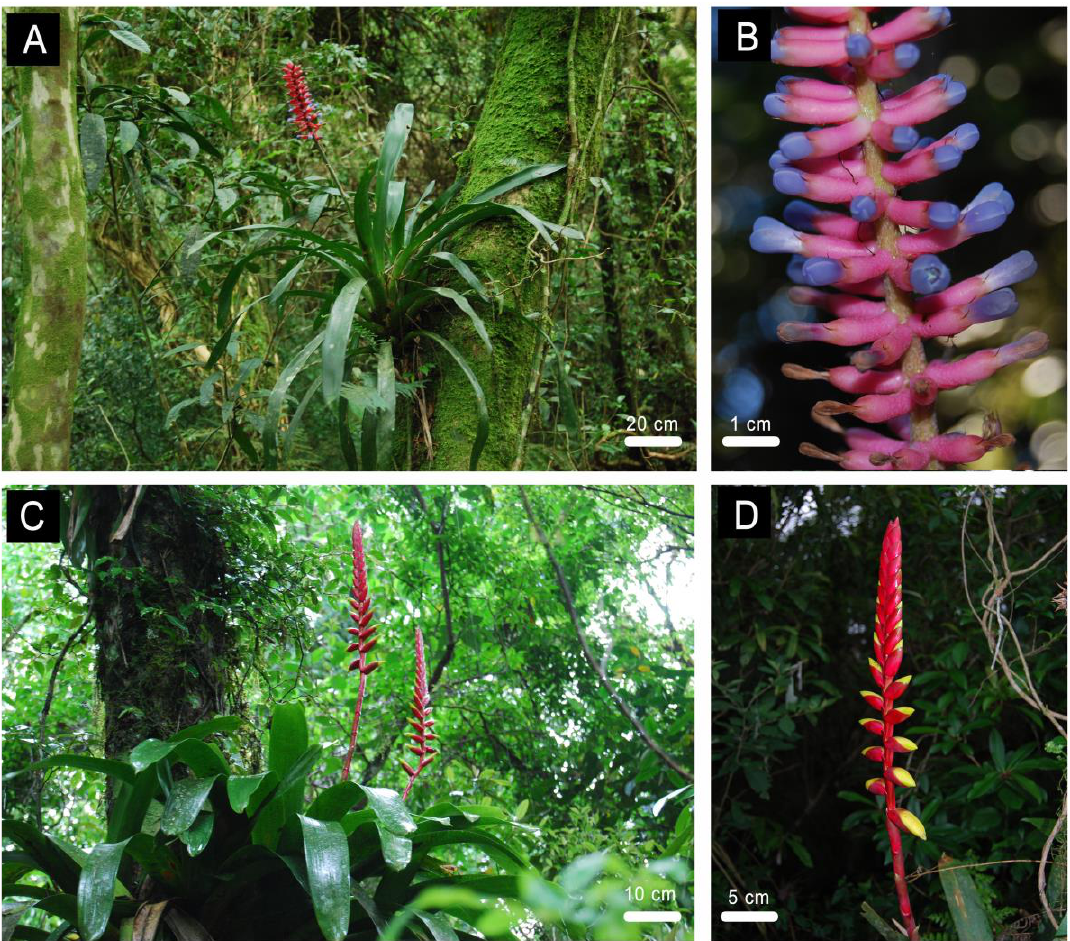
Figure 2. The two species of tank-forming bromeliads sampled in the Center for Research and Nature Conservation Pró-Mata. ( A ) Aechmea gamosepala (Wittm.); ( B ) A. gamosepala (Wittm.) flower detail; ( C ) Vriesea platynema (Gaud.); ( D ) V. platynema (Gaud.) flower detail. Photos: CPCN Pró-Mata Collection. Table 1. Field data from the sampled bromeliads and their water tanks.